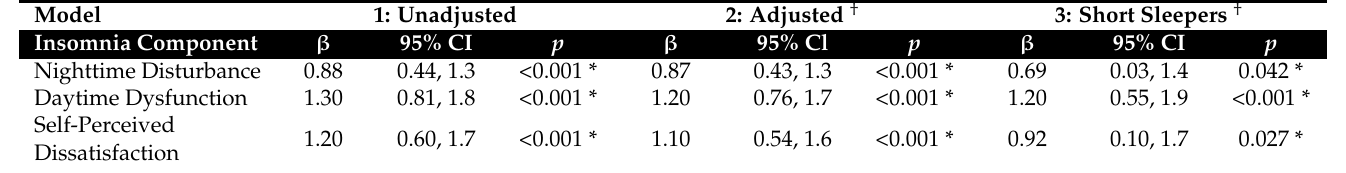
Table 2. Insomnia components and severity of anxiety in the whole sample and among short